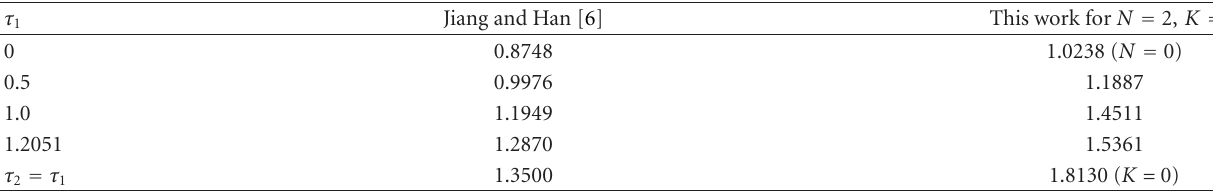
Table 2: MAUB of the time varying delay for di ff erent τ 1 .